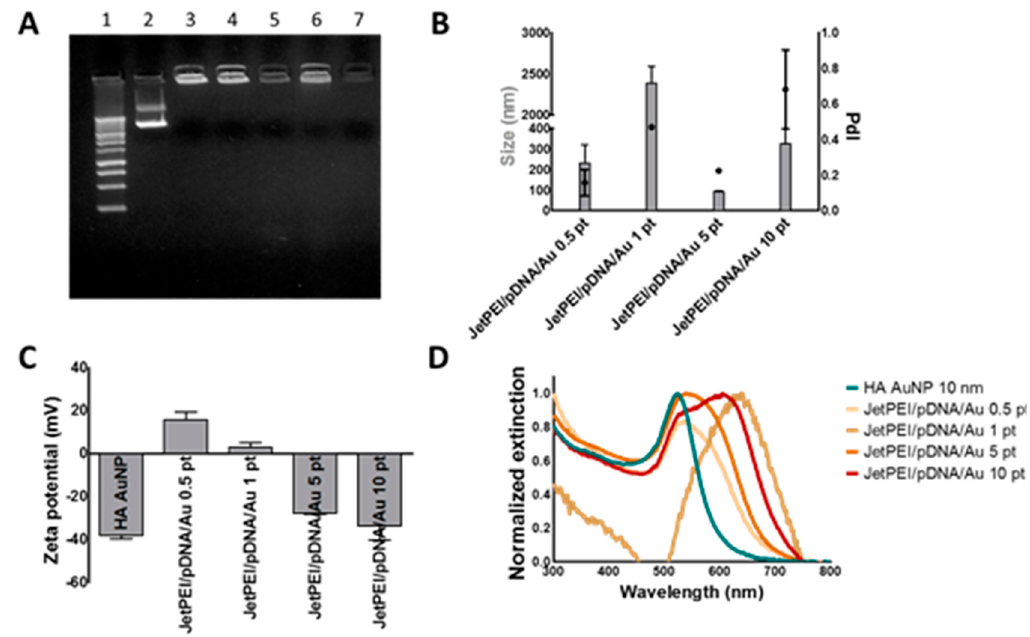
Figure 4. Characterization of JetPEI/pDNA/AuNP complexes. ( A ) gel electrophoresis shows successful pDNA complexation for all JetPEI/pDNA/AuNP complexes. Lane 1 shows a 1 kb ladder control. Lane 2 shows free pDNA. Lane 3 shows JetPEI/pDNA complexes prepared at an N/P charge ratio of 4. Lane 4, 5, 6 and 7 show JetPEI/pDNA/AuNP prepared with 0.5, 1, 5 and 10 pellets of AuNP, respectively. Further characterization of the complexes by dynamic light scattering reveals ( B ) the size (grey bars), PdI (black dots) and ( C ) Z potential. Values are displayed as mean ± stdev; n = 2; ( D ) normalized UV/VIS spectra of HA coated AuNPs (blue line) and JetPEI/pDNA/AuNP complexes (orange–red lines).